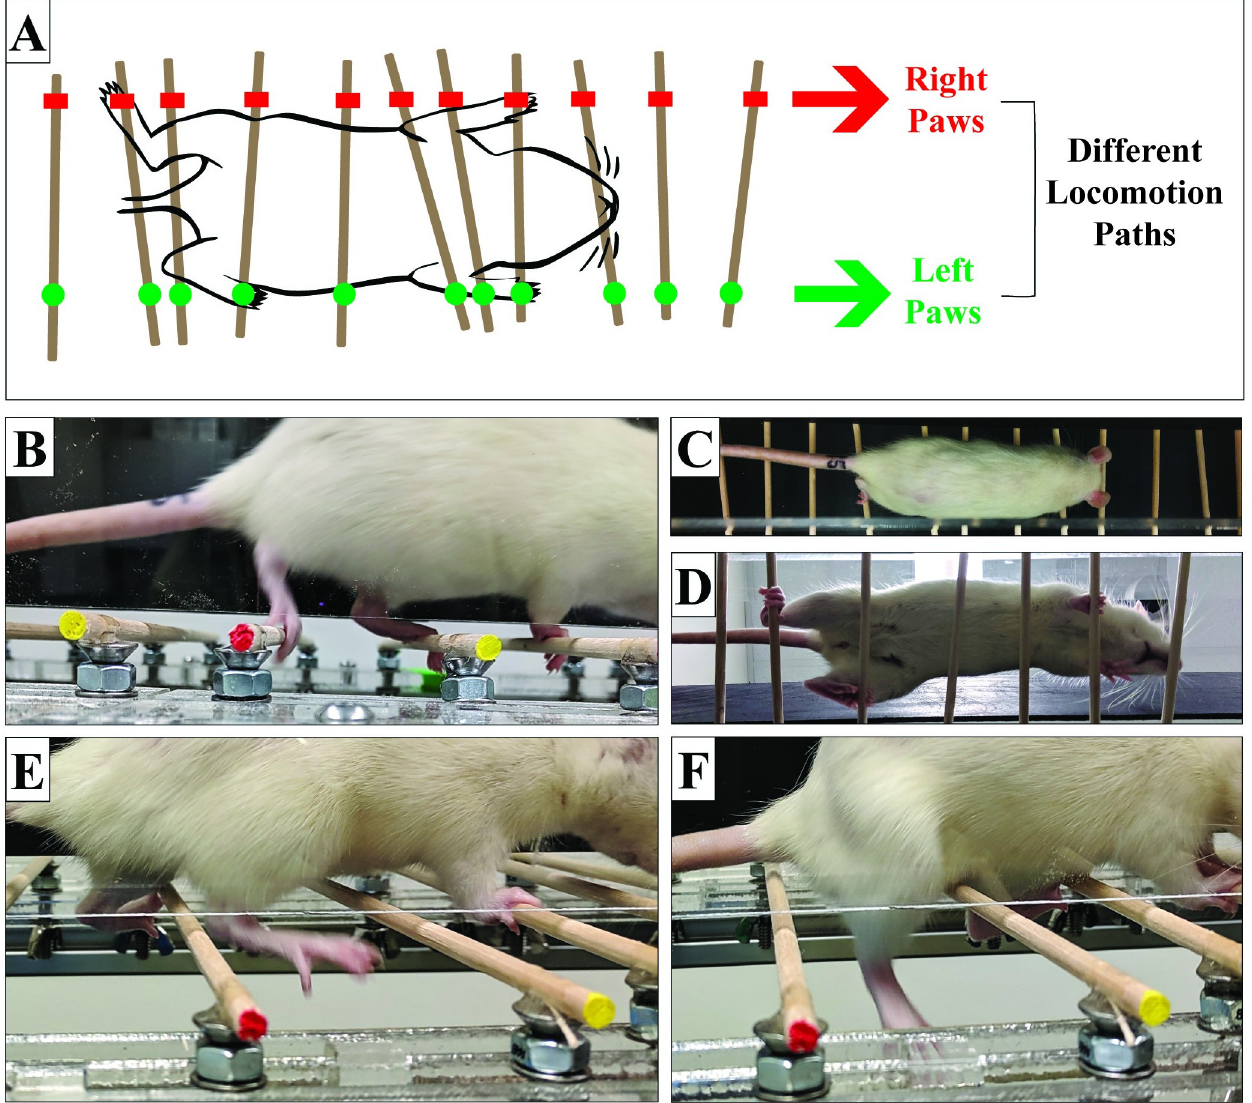
Fig 3. Rat locomotion on horizontal ladder walking task. (A) Illustrative rat locomotion from bottom view on novel asymmetrical ladder. (B-D) Rat walking with full weight bearing (e.g. “Hit”) from lateral view (B), top-down view (C), and bottom view (D). (E, F) Rat during a foot-fault event (e.g. “Miss”).